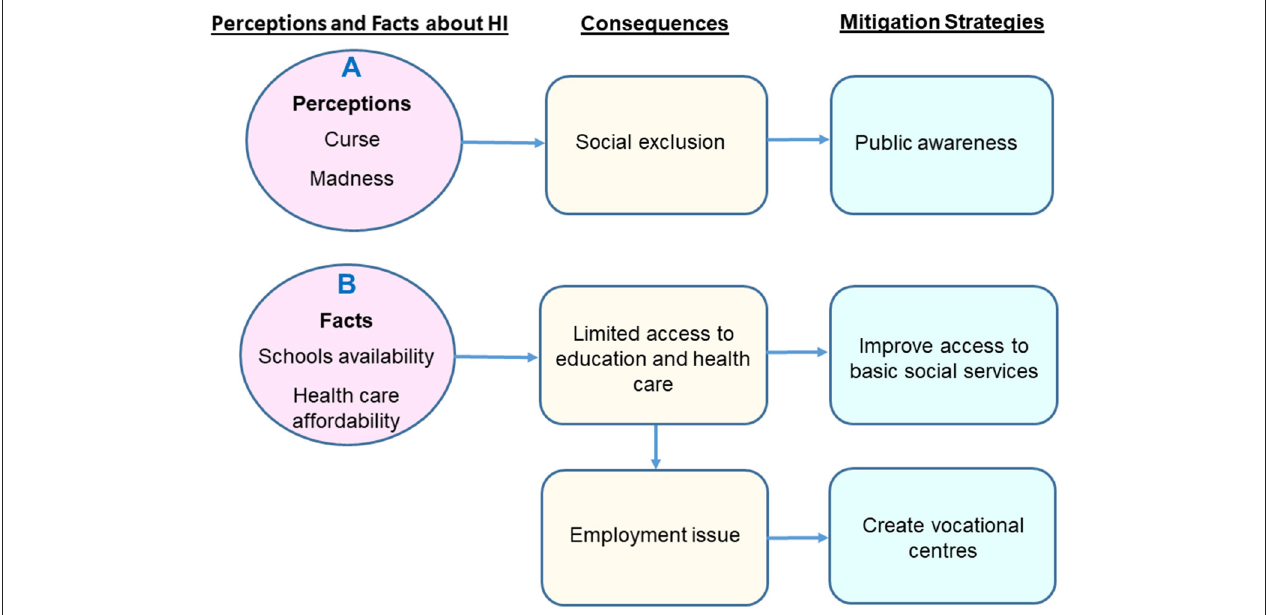
FIGURE 1 | Summary of the main findings. (A) The misunderstanding of the causes of HI leads to the social exclusion of people with HI. (B) The limited access to education and health care services constitutes a barrier to education and proper management.